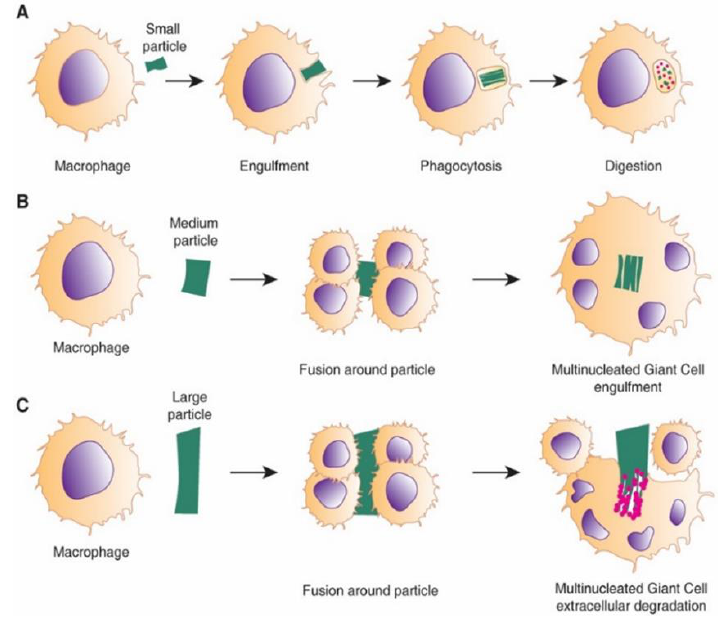
Figure 9. Schematic showing the process of FBGC formation by macrophages responding to foreign particles of di ff erent sizes. ( A ) Phagocytosis; ( B ) multinucleated FBGCs around the particle; ( C ) multiple FBGCs attempt to fuse around the larger particle causing extracellular degradation. Reproduced with permission of